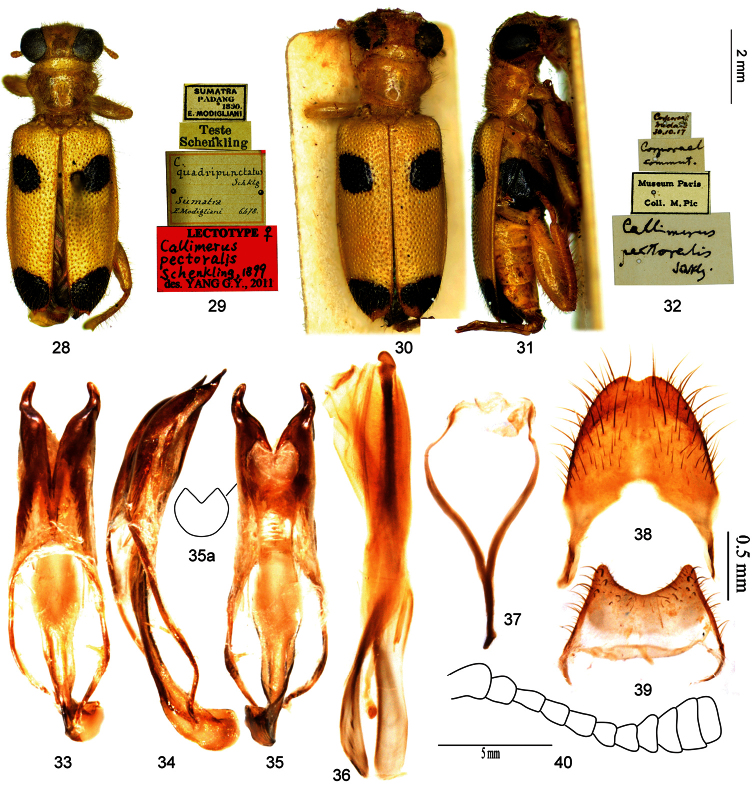
Callimerus pectoralis Schenkling, 1899. 28–29 lectotype of Callimerus pectoralis Schenkling, 1899 (28 dorsal view 29 labels) 30–32 a specimen determined by Schenkling as Callimerus pectoralis (30 dorsal view 31 lateral view 32 labels) 33–39 male terminalia, specimen from Sumatra 33–35 tegmen (33 dorsal view 34 lateral view 35 ventral view 35a outline of ventral membranous region) 36 phallus 37 spicular fork 38 tergite VIII 39 sternite VIII 40 antennae, specimen from Yunnan.